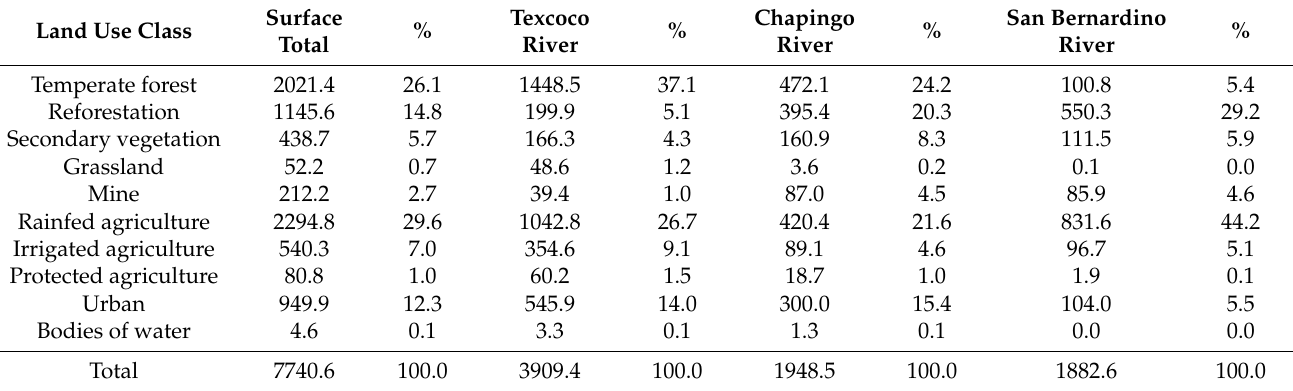
Table 1. Total and per ‐ microwatershed land use and vegetation cover areas.